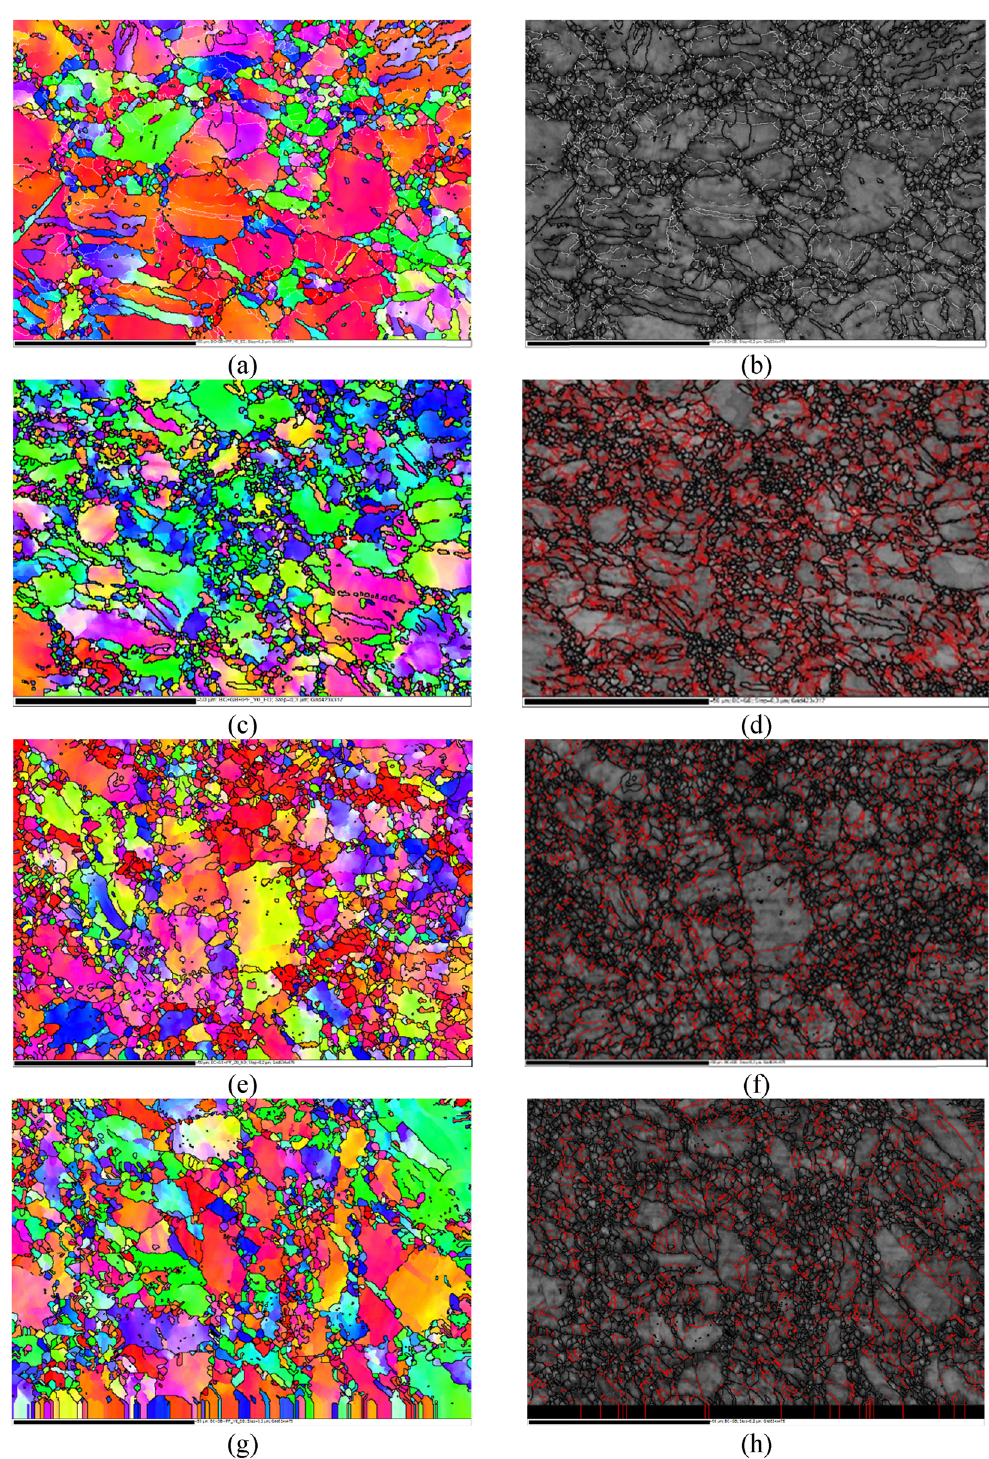
Figure 5: IPF coloring maps and their corresponding band BC maps with high - angle boundaries > 15° in black lines and low - angle boundaries 3 – 15° in white lines ( b ) and ( d, e, h ) red lines, superimposed for the Mg billets processed through ( a and b ) 1 - pass or ( c and d ) 2 - passes of route A, ( e and f ) 2 - passes of route Bc, and ( g and h ) 2 - passes of route C using the ECAP die with channel angle of